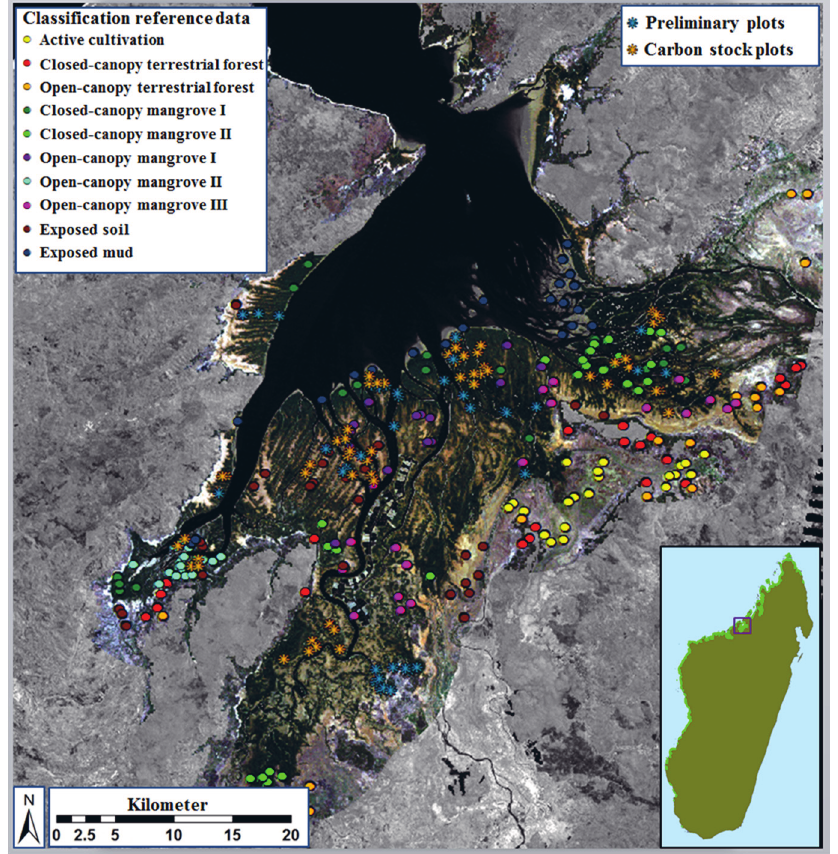
Figure 2. The locations of 43 preliminary mangrove plots and 243 reference areas used to calibrate ( i.e. , 163) and validate ( i.e. , 80) image classification. Also shown are the locations of 51 carbon plots. The AOI extent is shown using a masked true color composite of Landsat 5 Thematic Mapper (TM) bands 1, 2, and 3, wherein vegetation appears primarily in shades of green. The background image is Landsat 5 TM band